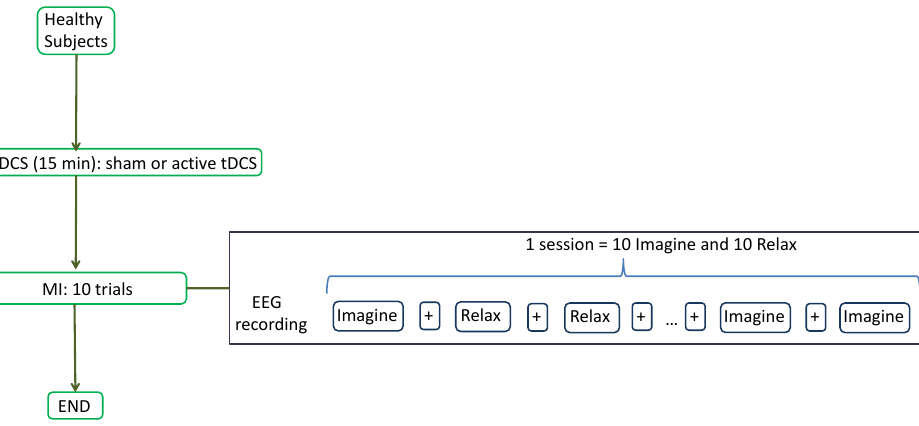
Figure 1. Flow diagram of the experiment for healthy subjects. The subjects were instructed by the screen to perform one of two possible mental tasks: Relax or Imagine . During Relax , subjects had to try not to think about anything, while, during Imagine , they had to imagine themselves pedaling. The Relax and Imagine tasks appeared at random and were always separated by an intermediate period (indicated by the screen with a + symbol). The setup also prevented two tasks of the same type to appear more than two times